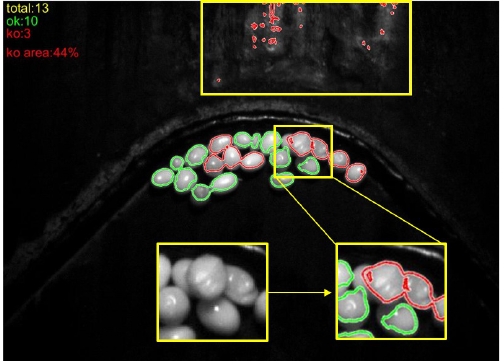
Figure 11. Example of false positives in an image with a low number of olives or set of olives regions. The top shows false positives because of the conveyor belt glows. The bottom shows false positives originating by the overlap of olives.